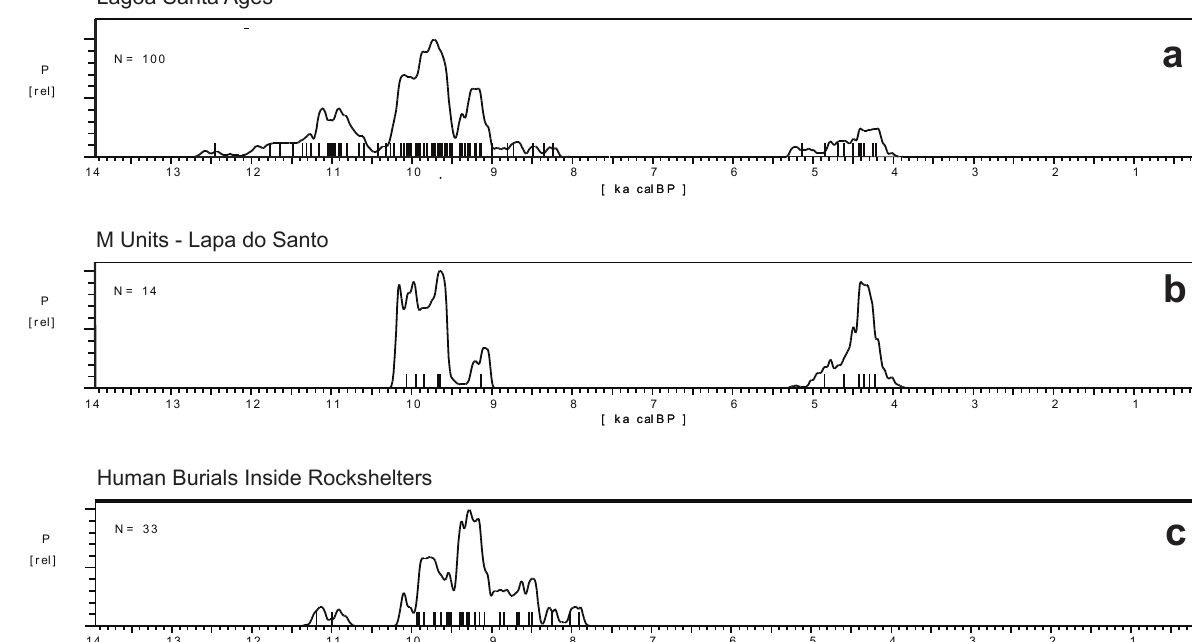
Figure 13 - Summed radiocarbon probability distribution curves for Lagoa Santa region. a : Consolidated data for the whole region; b : Ages obtained for charcoal in the “M Units”; c : Ages obtained for human burials inside several